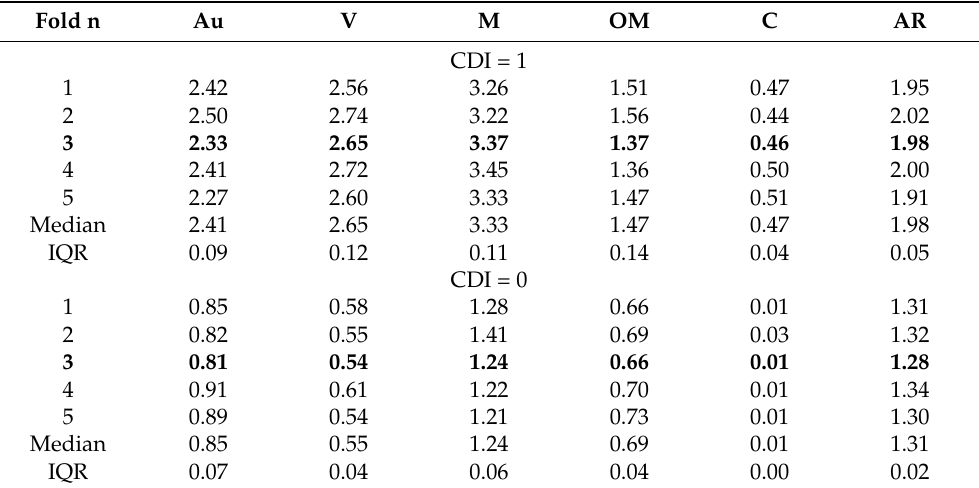
Table 2. Cluster centroids for each cross-validation fold and related medians and IQR.